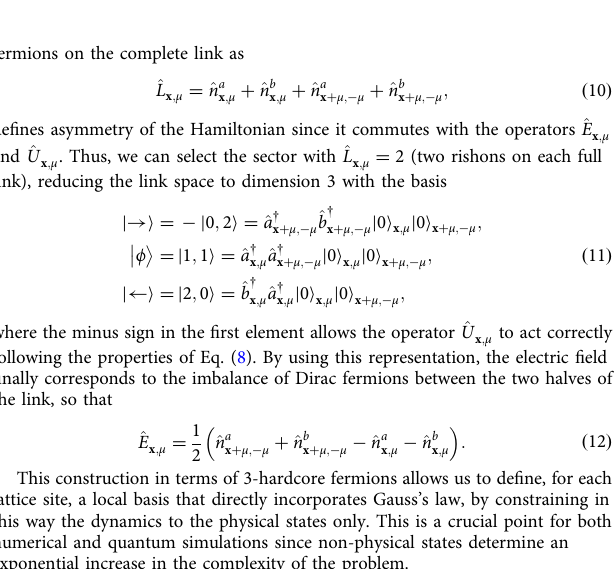
Fig. 6 Construction of the gauge-invariant con fi gurations for the local sites. a Representation of the gauge fi eld in terms of two species of Dirac modes in the sector with a total number of fermions equal to two. b Generic state of the local site composed by the matter degrees of freedom and six half-links along with the three spatial directions. On each half-link, the coef fi cients k j ∈ {0, 1, 2} de fi ne the fermionic modes. c Examples of gauge-invariant con fi gurations for even and odd sites. Due to the use of staggered-fermions, the presence/absence of a fermion in an even/odd site represents the presence of a